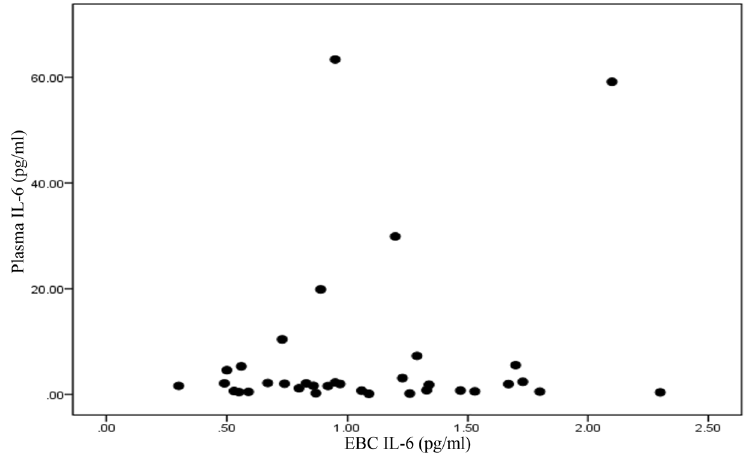
Figure 8. The concentration of IL-6 in Blood and EBC second sampling